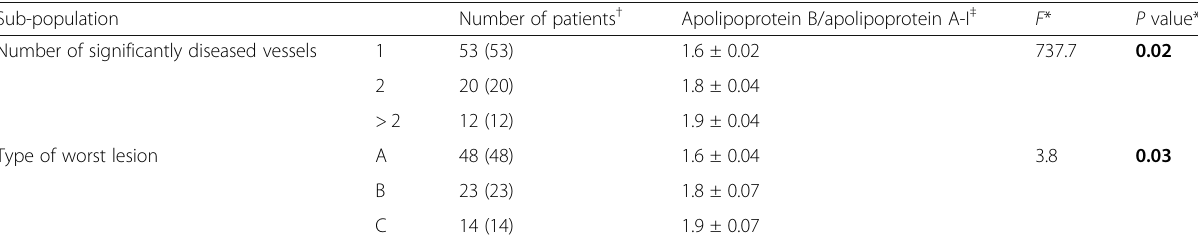
Table 3 Mean ApoB/Apo A-I ratio in relation to the number of significantly diseased coronaries and type of coronary lesions in NSTE-ACS group